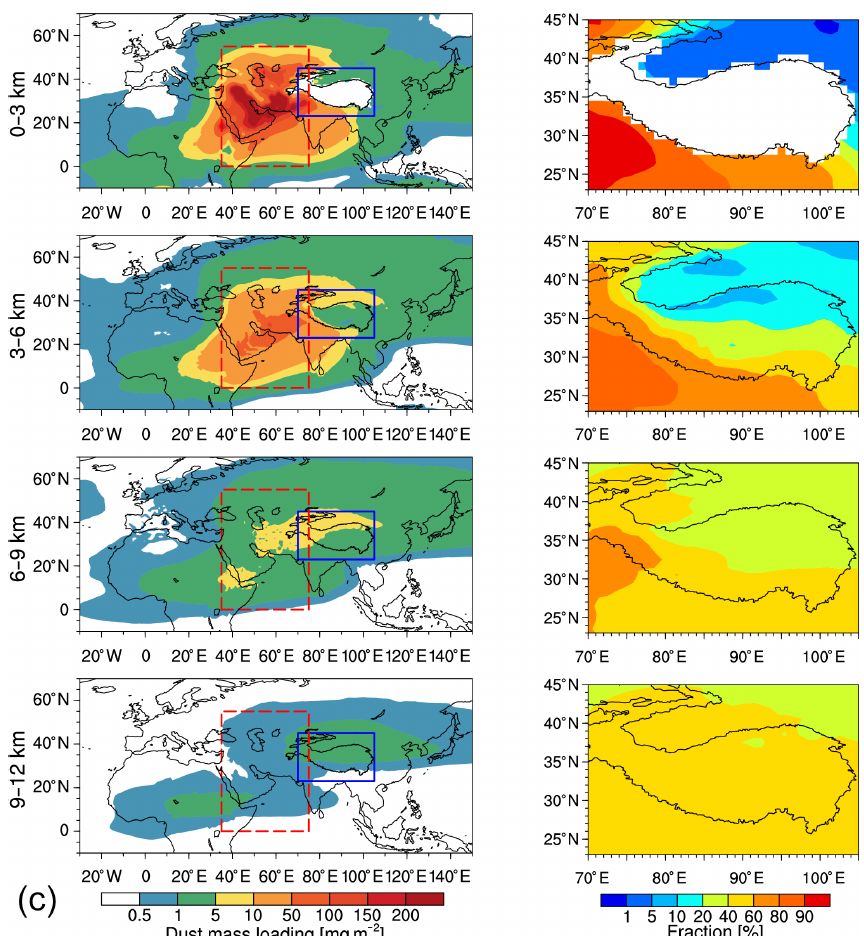
Figure 4. (a) Spatial distributions of (left) annual mean dust mass loading (in milligrams per square meter) emitted from East Asia between 0–3, 3–6, 6–9, and 9–12km and (Right) the corresponding fractions compared with total dust mass loading over TP. The box in red dotted lines shows the dust source regions, while the box in blue solid lines shows the TP regions in this study. The purple solid lines are at 75, 90 and 102 ◦ E for the dust height–latitude cross sections. (b) Same as (a) but for dust emitted from North Africa. The purple solid lines are at 24, 36 and 38 ◦ N for the dust height–longitude cross sections. (c) Same as (a) but for dust emitted from the Middle